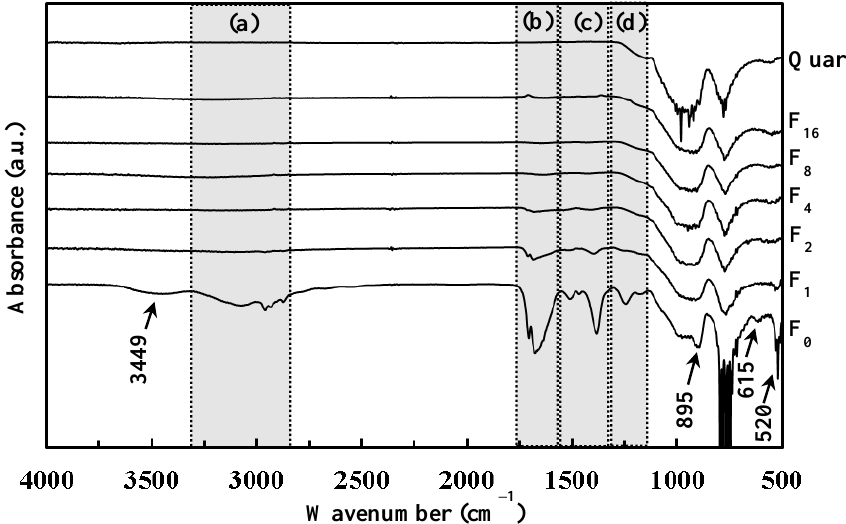
Figure 4. Fourier transform-infrared (FT-IR) spectra of F 0 , F 1 , F 2 , F 4 , F 8 , F 16 , and quartz glass substrate. The peaks in each dotted region correspond to the ( a ) C–H stretching mode of CH 2 /CH 3 groups, ( b ) C=O stretching mode, ( c ) C–H bending mode of CH 2 /CH 3 groups, and ( d ) C–O stretching mode, respectively. The peaks of 895, 615, are 520 cm − 1 are assignable to the O–O stretching of side-on peroxo group bonded to Ti(IV) ion (Ti–O 22 − ), to the Ti–O 22 − symmetric stretching mode, and to the Ti–O 22 − asymmetric stretching mode, respectively.